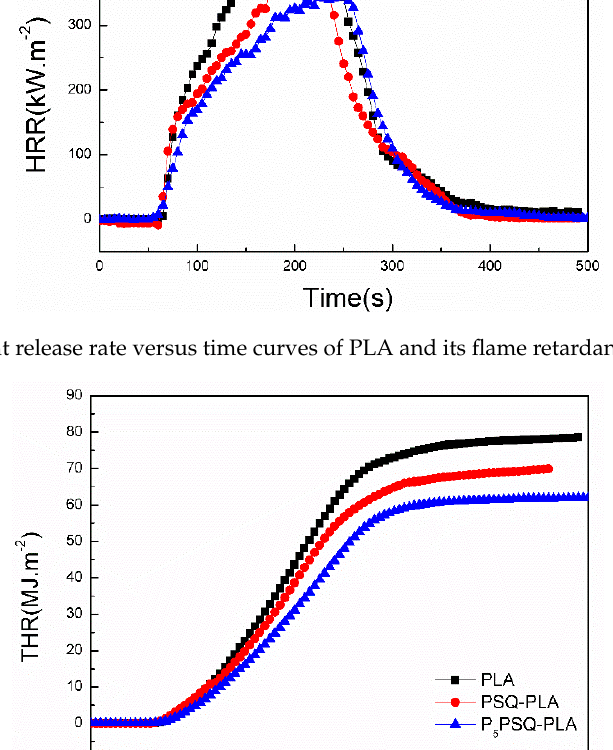
Figure 5. Total heat release versus time curves of PLA and its flame retardant composites.